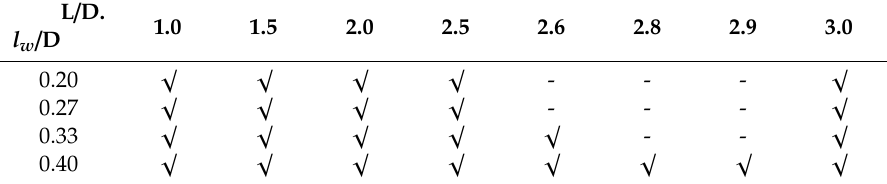
Table 1. Parameters of the flow control simulation at Re = 200. Re: Reynolds number. 𝐋 𝐃⁄ .